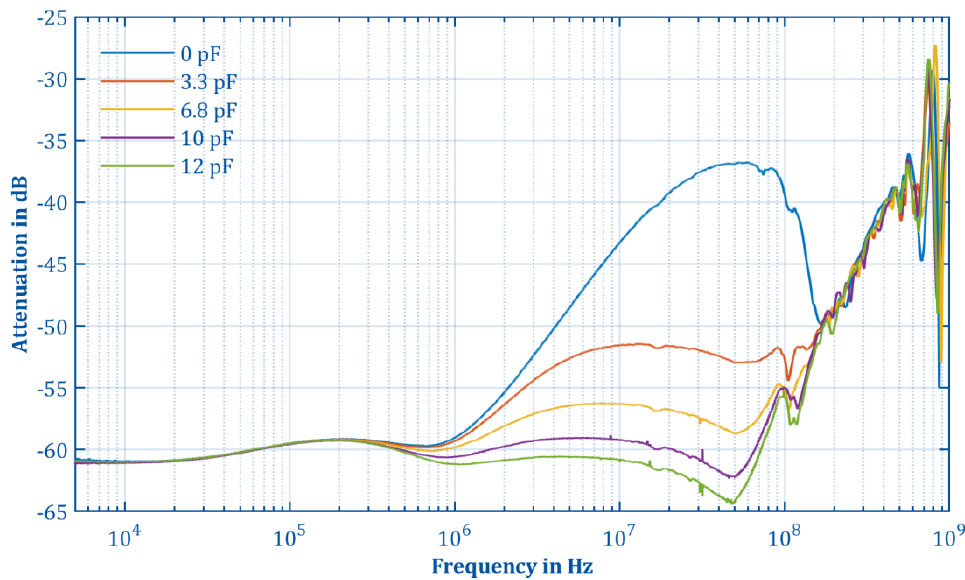
Figure 11. Transmission responses with different capacitors C X for high-pass compensation of the resistive voltage divider with the discrete compensation electrode geometry.